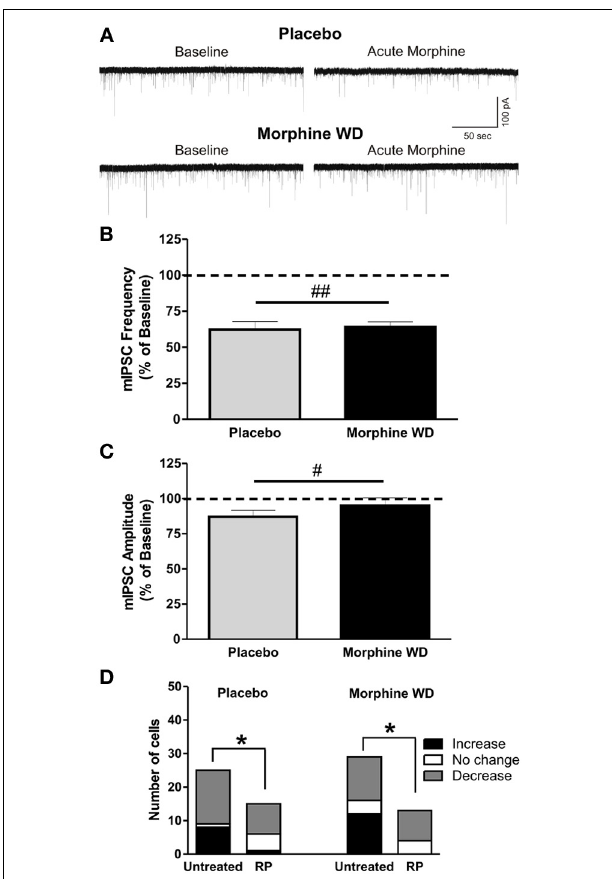
FIGURE 4 | RP inhibition of cAMP prevents enhancement of GABAergic transmission induced by acute morphine application. (A) Represen- tative recordings from CeA neurons from placebo and morphine WD rats pre-treated with RP. (B) After RP (500nM) pre-treatment, acute morphine (10 μ M) gave a significant main inhibitory effect on mean mIPSC frequencies and amplitudes (C) of CeA neurons from placebo ( n = 10) and morphine-withdrawn ( n = 9) rats. Statistical significance ( # p < 0 . 05 and ## p < 0 . 01) was calculated by Two-Way ANOVA. (D) In CeA from both placebo and WD rats, RP-pretreatment significantly reduced the number of CeA neurons responding to acute morphine by an increase in mIPSCs, as calculated by Chi-square test ( ∗ p < 0 .